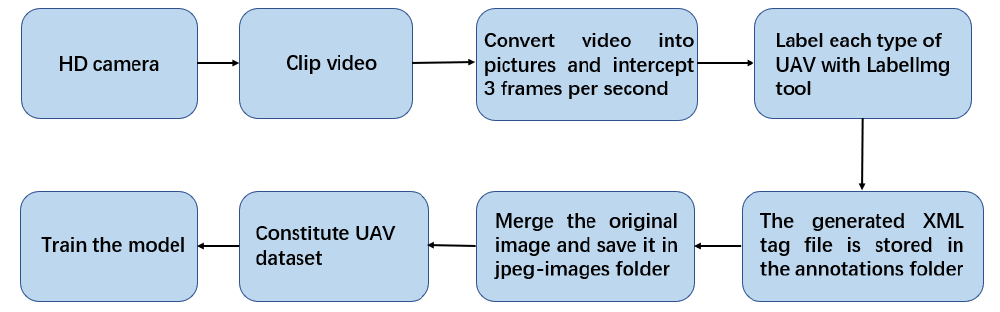
Figure 2. Flowchart for making a UAV